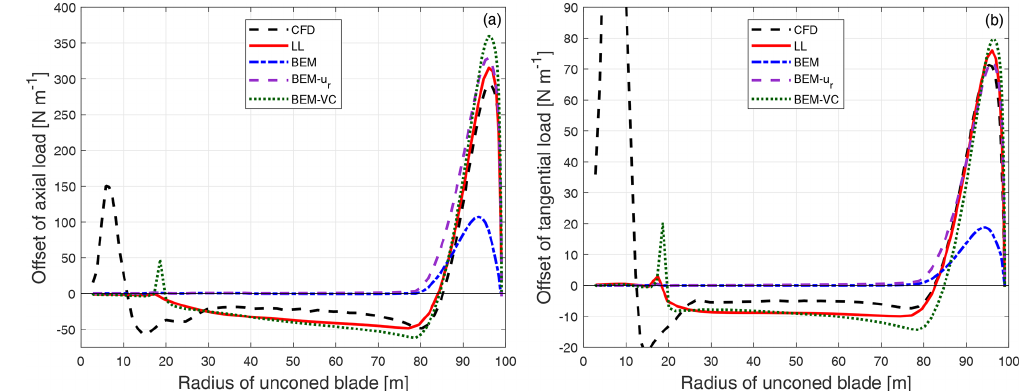
Figure B9. Comparison of the difference of the axial load (a) and tangential load (b) of the dihedral blade W-4 with 15 ◦ of cone downwind compared to the baseline blade with the same cone calculated from different aerodynamic